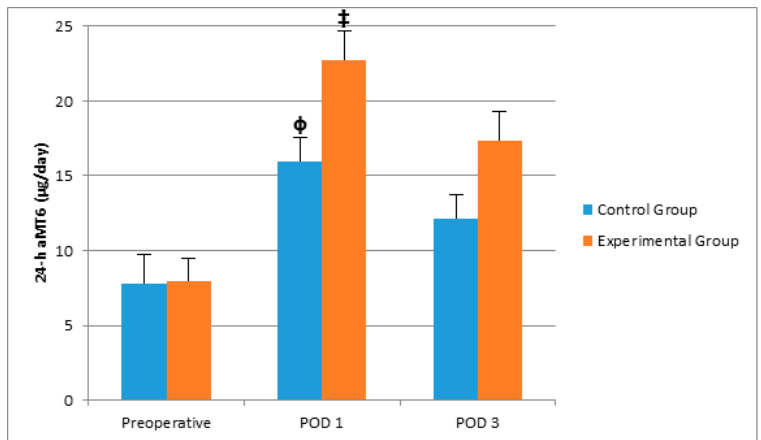
Figure 4. The effects of controlling noise and light in ICU on 24-h aMT6 levels after major abdominal surgery. Φ p < 0.05 versus preoperative levels in the control group, ‡ p < 0.05 versus preoperative levels in the experimental